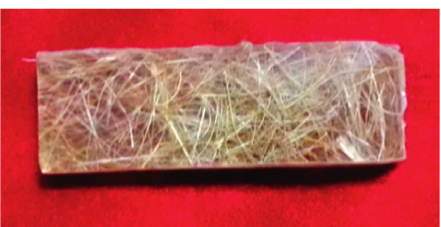
Figure 4: Shore D hardness specimen. Table 2: Outline of Flexural strength with the influence of parameters.